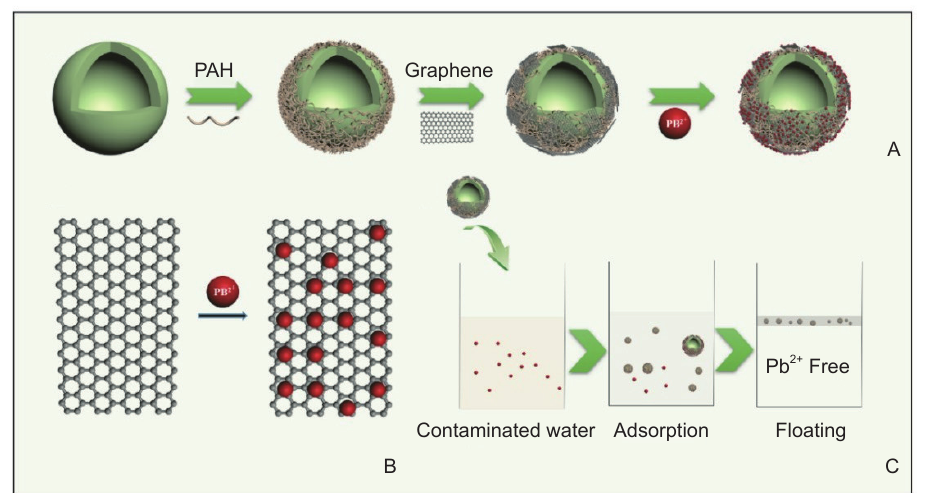
Figure 4 Schematic illustration of preparation and absorption process of GO/PLA microbubbles (PLA@GO).